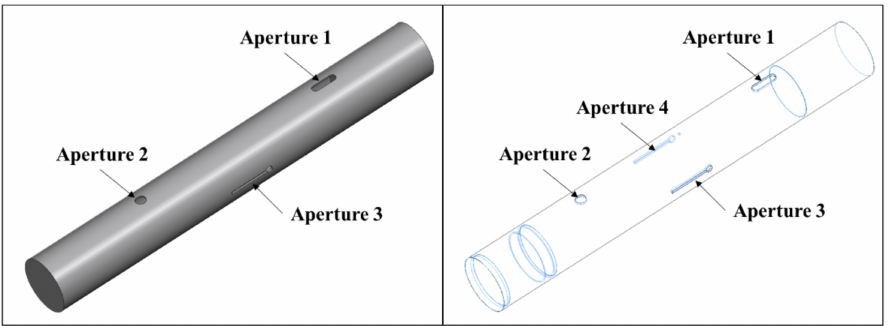
Figure 2. Simplified GENEC model with 4 apertures.